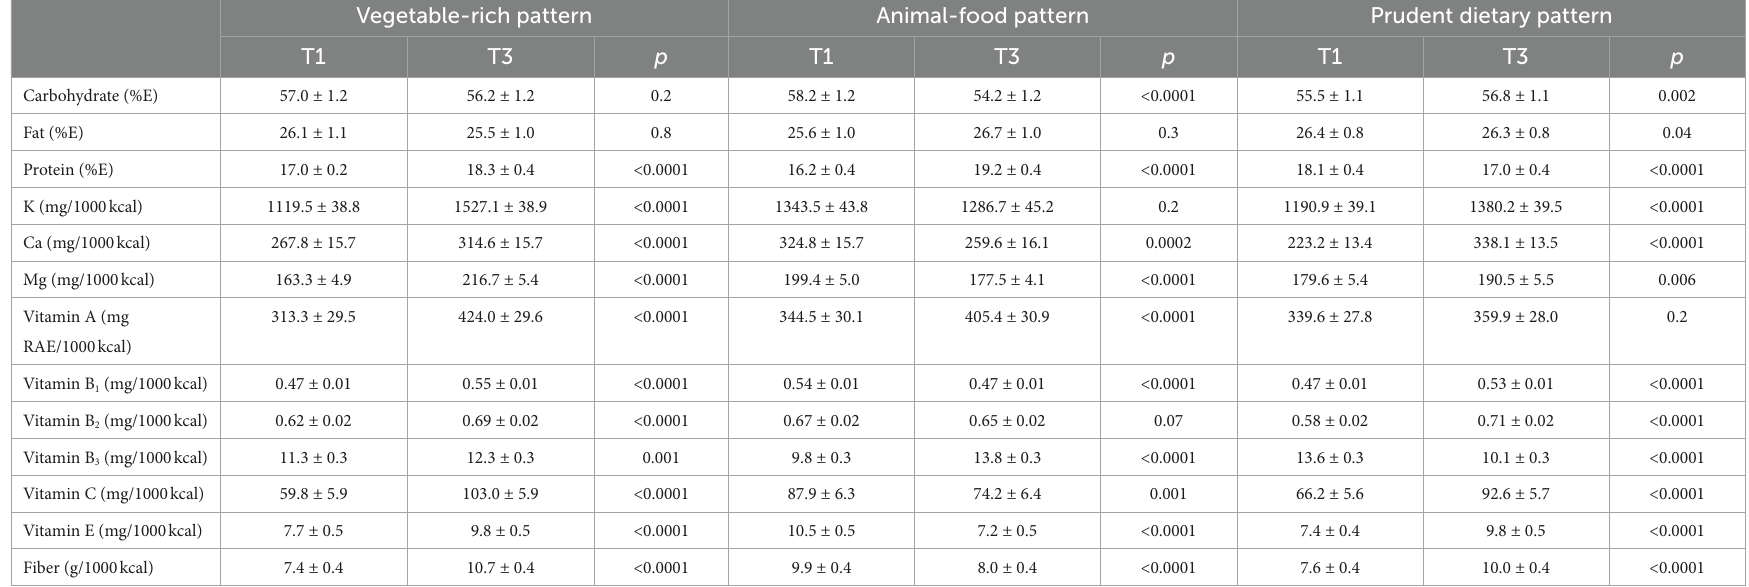
TABLE 4 Mean nutrient intakes for tertile of dietary pattern score a . Vegetable-rich pattern Animal-food pattern Prudent dietary